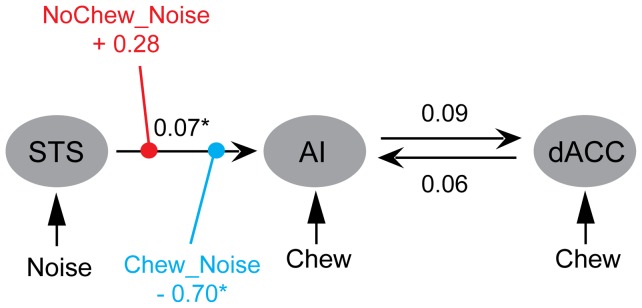
The structure and parameters of the model with the best fit (Model 1).The black lines illustrated the intrinsic connectivities between brain regions. Intrinsic connectivity refers to the connectivity between regions across the whole scanning session, irrespective of stimulus and task. In color are the modulations of stimulus/task on the intrinsic connectivities. The numbers are the strength of connectivity (Hz). * p<0.05, corrected for multiple comparison with Bonferroni's procedure.